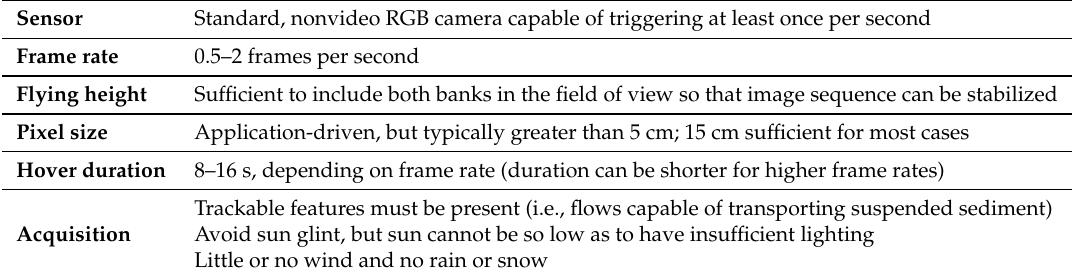
Table 5. Guidelines for data collection to support PIV on sediment-laden rivers in